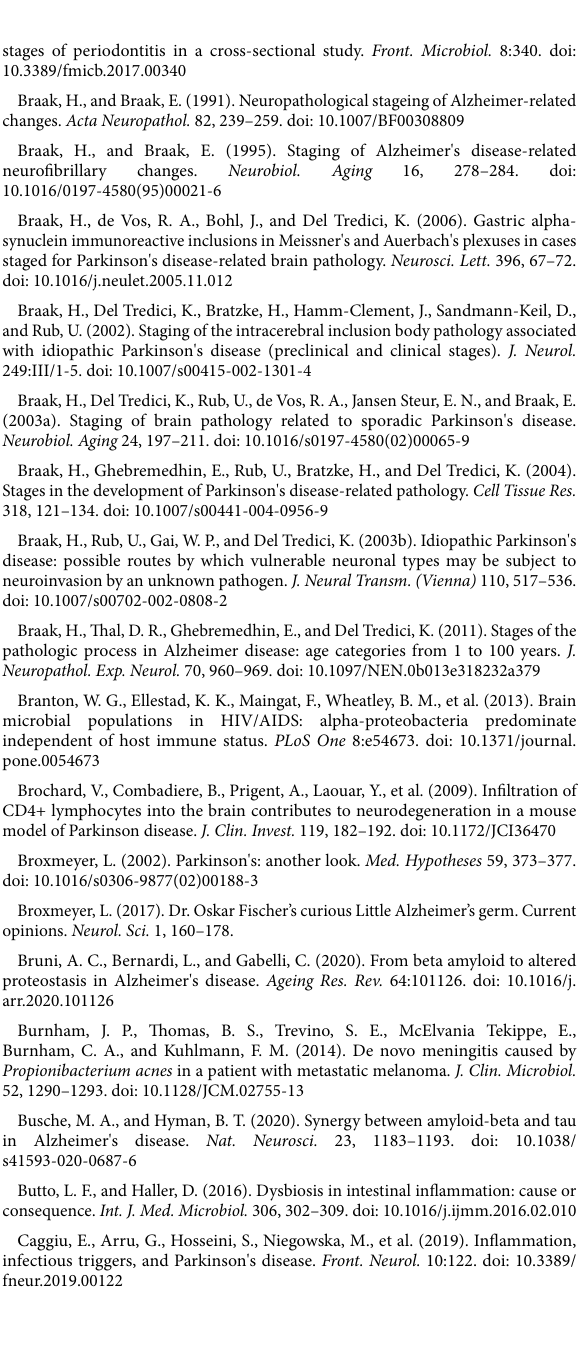
SUPPLEMENTARY FIGURE 2 Clustal Omega Alignment Analysis of uncharacterised Cutibacterium OTUs. This indicates notable clustering of AD exclusive OTUs. AD, Alzheimer’s disease; PD, Parkinson’s disease. ALL-AD; PD; Control and NTC; EC, entorhinal cortex; NTC, no template control. SUPPLEMENTARY FIGURE 3 Beta diversity boxplots depicted by (A) unweighted Unifrac and (B) Unifrac weighted by phylogenetic distance, both showing significant differences between groups especially pairings including EC-C or LC-AD. SUPPLEMENTARY FIGURE 4 Beta diversity Heatmap (weighted Unifrac distance). Heat map showing the beta diversity dissimilarity coefficients between brain samples.